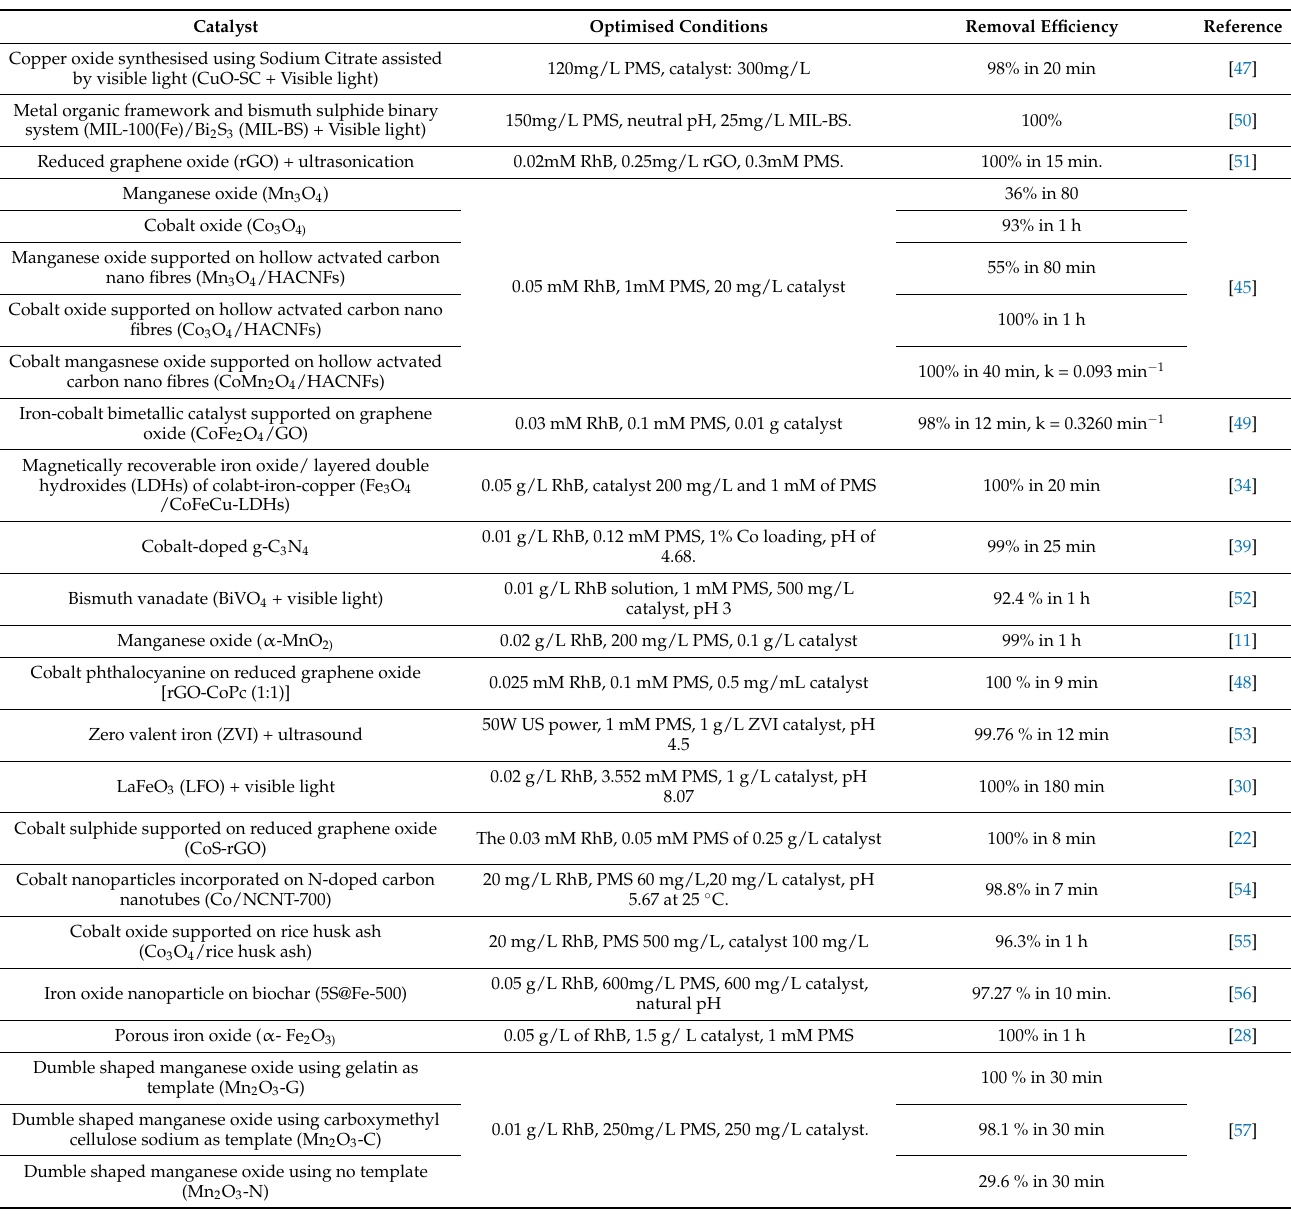
Table 1. Performance of PMS activated by various catalysts and its comparison with the present study. Optimised